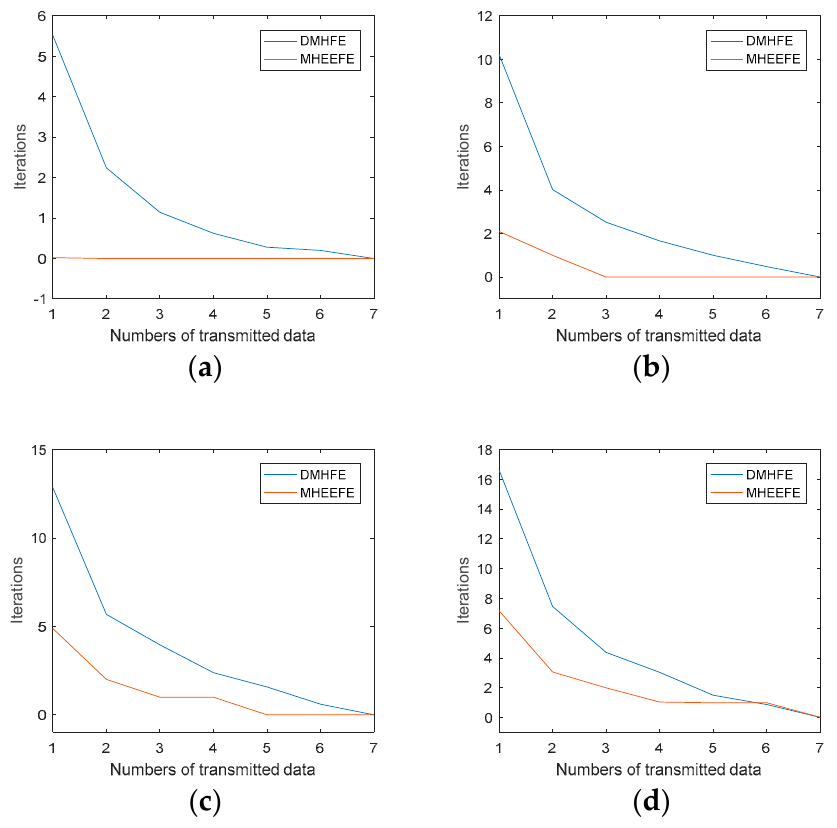
Figure 4. Iterations when the number of transmitted data changed: ( a ) The number of drastically changed components is 1; ( b ) The number of drastically changed components is 3; ( c ) The number of drastically changed components is 5; ( d ) The number of drastically changed components is 7.